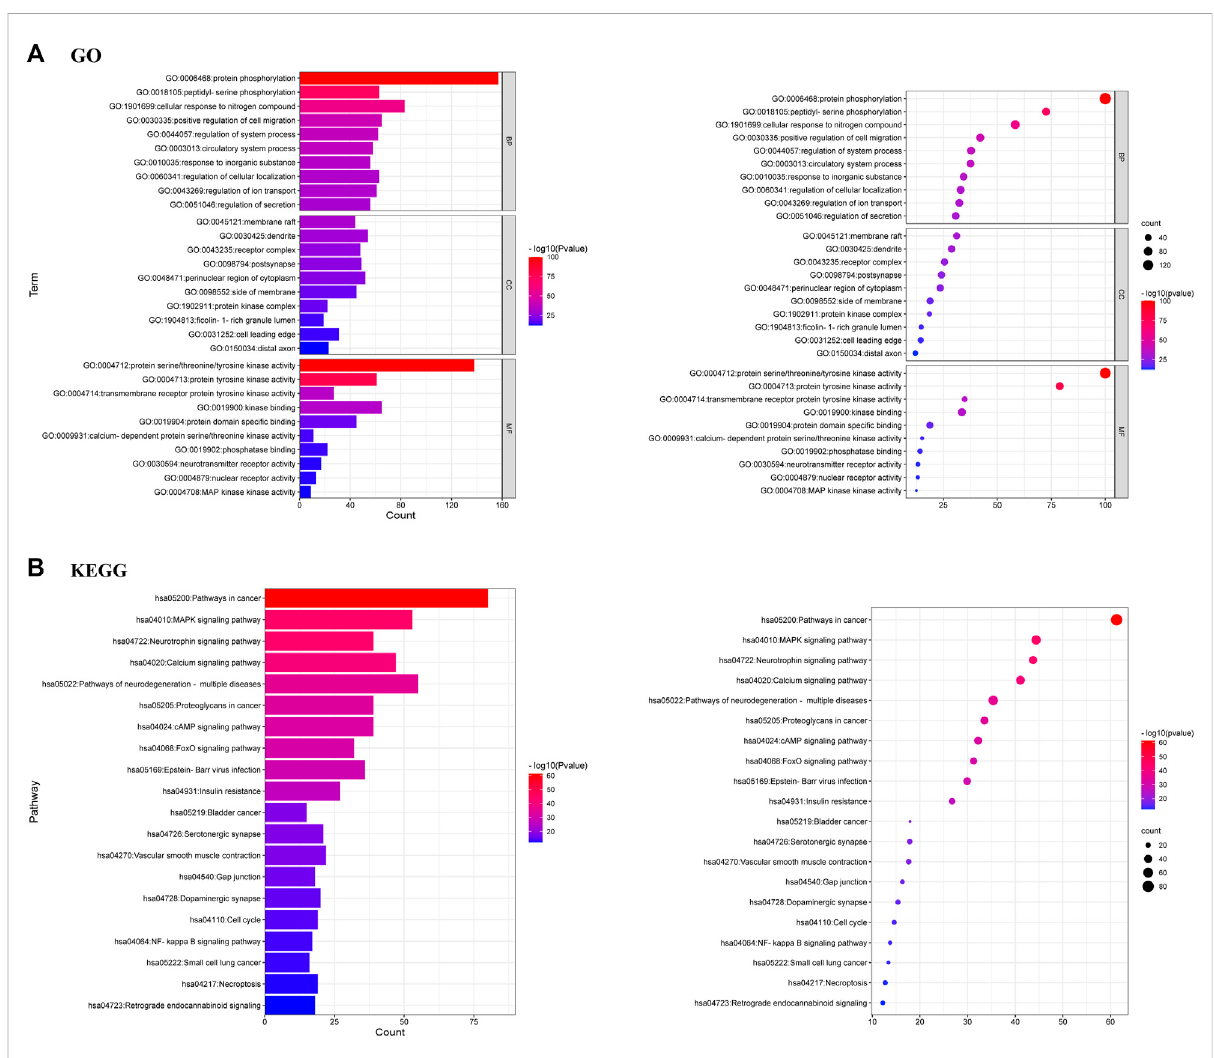
FIGURE 6 (A) GOanalysisof381commontargets[Biologicalprocesses(BP),Molecularfunctions(MF)andCellularcomponents(CC)] (B) KEGGanalysisof 381 common